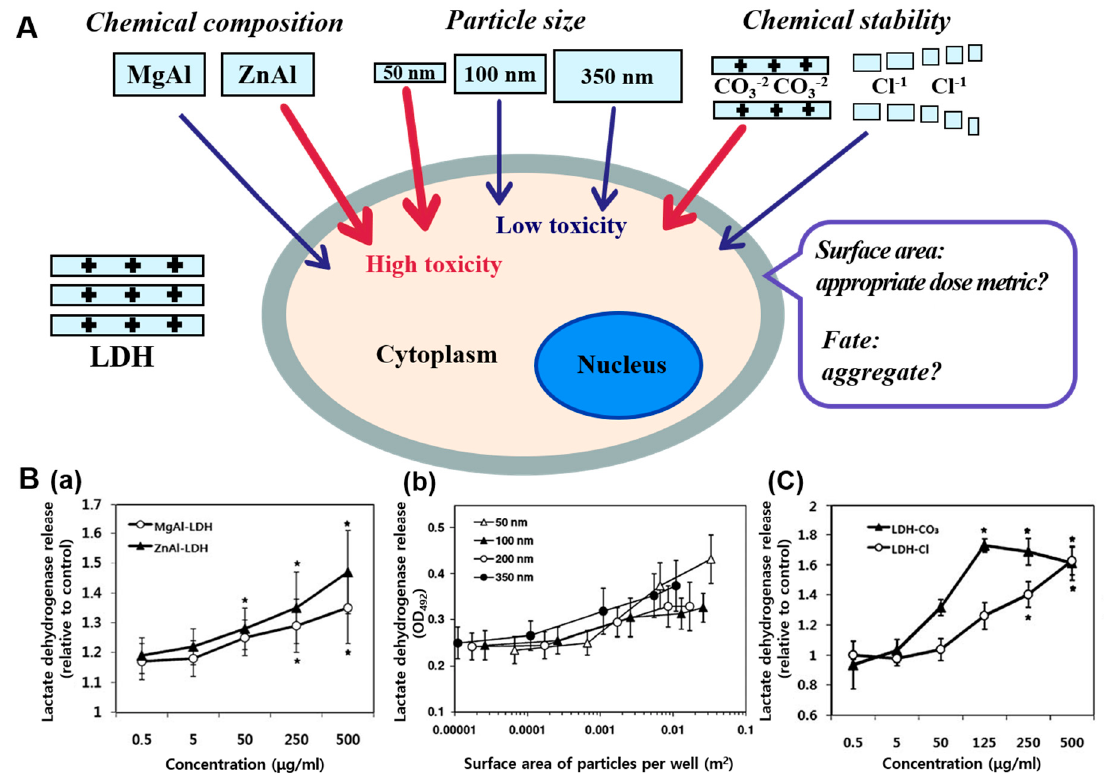
Figure 3. ( A ) Schematic illustration of the correlation between the chemical composition, particle size, and chemical stability of LDHs and the cytotoxicity. ( B ) Cytotoxicity of LDH nanoparticles with respect to ( a ) chemical composition, ( b ) particle size, and ( c ) chemical stability as measured by released lactate dehydrogenase levels in vitro (the blue arrows for low toxicity and the red arrows for high toxicity), reproduced from [25].